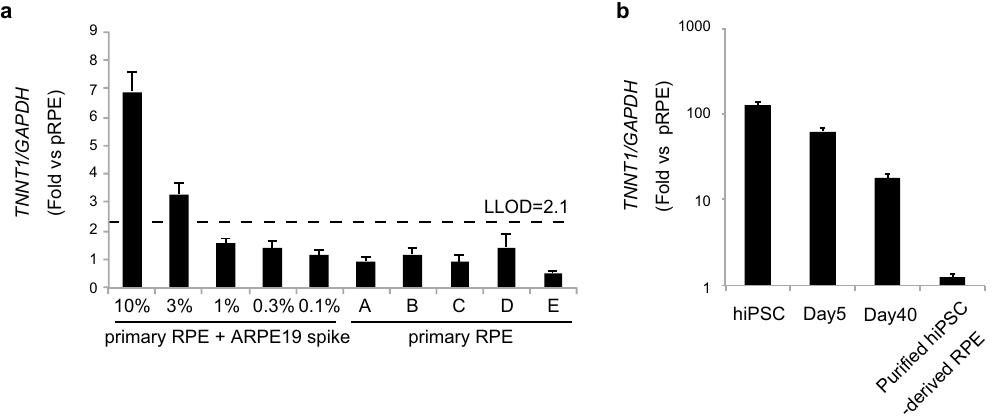
Figure 4. Validation of the TNNT1 qRT-PCR assay. (a) qRT-PCR analysis of TNNT1 mRNA expression in primary RPE cells spiked with different amounts of ARPE19 cells and 5 lots of primary RPE cells. The LLOD (dashed line) was determined as described in the Results section. (b) Time course of the expression of TNNT1 mRNA during differentiation of hiPSCs to RPE cells. All values are expressed as mRNA levels relative to the mean of 5 lots of primary RPE cells. Results are means ± standard deviations (n =